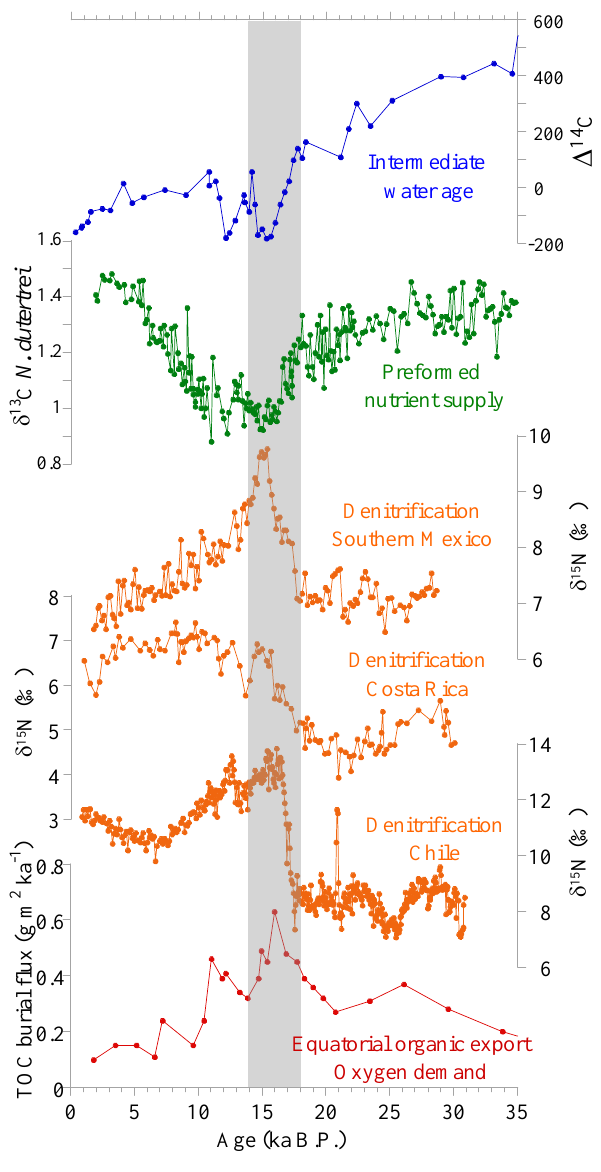
Fig. 3. Downcore profiles of organic export flux representative of the EEP as represented by 230 Th normalized TOC flux at Site ME005A-24JC (from Kienast et al., 2006), of δ 15 N representative of water-column denitrification off Costa Rica (ODP Site 1242, this study), off Chile (Core GeoB7139-2 from De Pol-Holz et al., 2006), off Southern Mexico in the Gulf of Tehuantepec (Core ME0005A- 11PC from Hendy and Pedersen, 2006), of planktonic foraminiferal δ 13 C ( N. dutertrei from Site 1240; Pena et al., 2008), and of and ra- diocarbon composition of benthic foraminifera from offshore Baja California in the northeast Pacific (from Marchitto et al., 2007). The shaded area highlights the interval of the deglaciation characterized by higher export production synchronous with higher water-column denitrification, driven by higher nutrient supply in the EEP and an increase in the influx of old and nutrient-rich bottom waters toward the